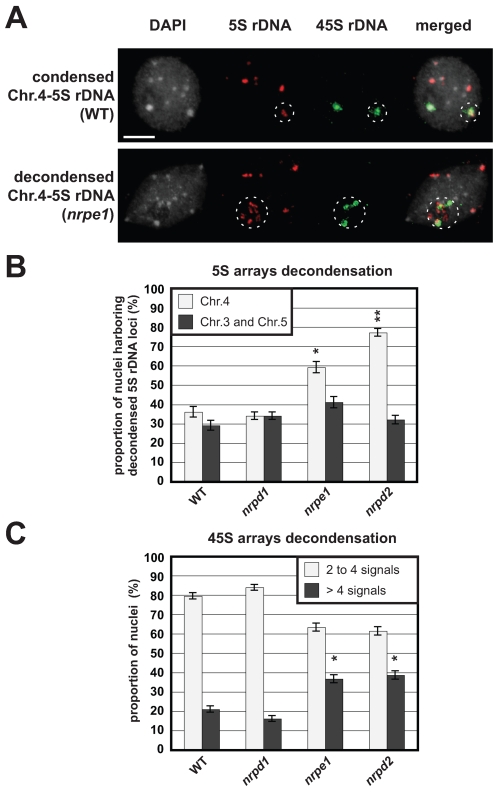
Compaction of rDNA arrays.(A) Representative images of condensed and decondensed 5S rDNA locus from chromosome 4. Counterstaining with DAPI (left); FISH with a 5S rDNA probe (red); FISH with a 25S rDNA probe which reveals the 45S locus (green); and the merged image on nuclei from WT and nrpe1 nuclei. Associated 5S and 45S rDNA loci from chromosome 4 are circled. In both cases (WT and nrpe1), 5S signals from the two chromosomes 4 are present in the white circle. Non circled 5S-red signals are from chromosomes 3 and 5. Bar = 5 µm. B) Proportion of nuclei, derived from 45 to 62 nuclei analysed, harboring decondensed 5S signals. 5S signals from chromosome 4 were analysed separately whereas 5S signals from chromosomes 3 and 5 were considered together. Asterisks denote significant differences to the corresponding (chromosome 4 or 3 and 5) WT value. (Z-test, * P<0,05 , ** P<0,01). Interval confidence with a confidence level of 99% is shown on each bar. (C) The percentage of nuclei harboring 2 to 4 NOR loci (grey) and more than 4 NOR loci (black) was estimated from 45 to 62 nuclei analysed in WT, nrpd1, nrpe1 and nrpd2 plants. Asterisks denote significant differences to the WT value. (Z-test,* P<0,05). Interval confidence with a confidence level of 99% is shown on each bar.